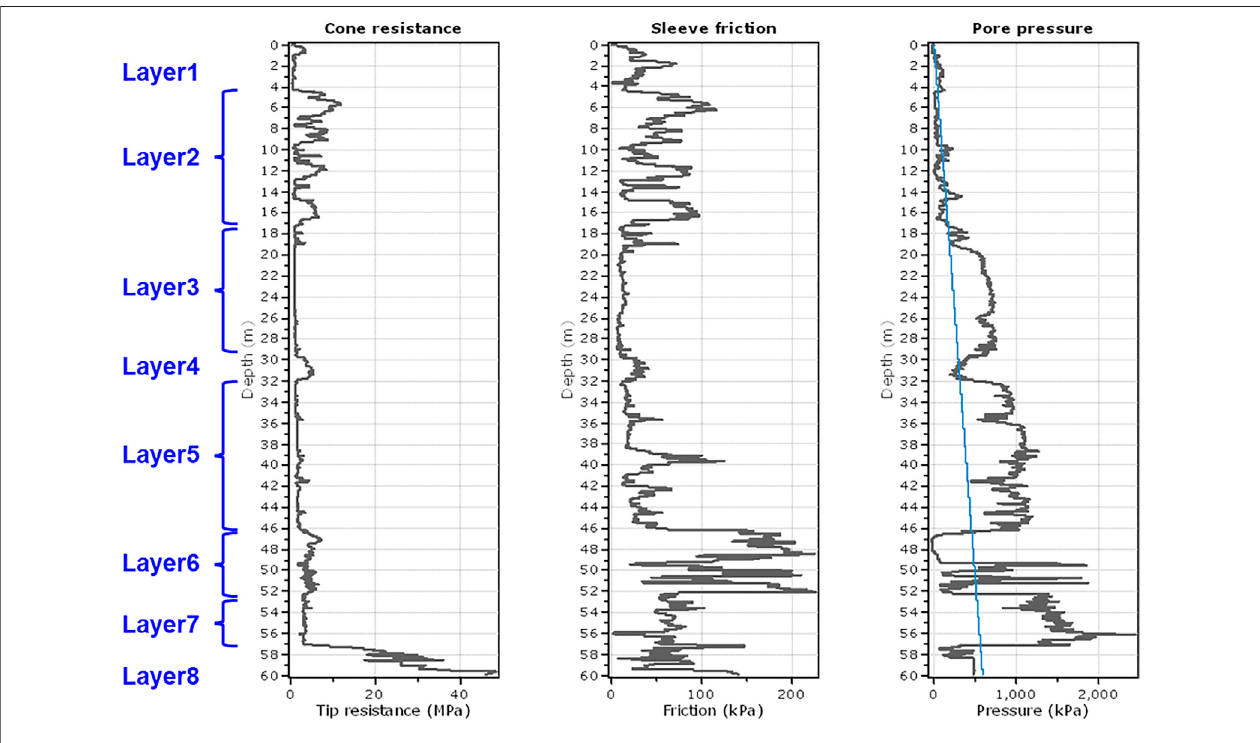
FIGURE 2 | CPTU interpretation data.